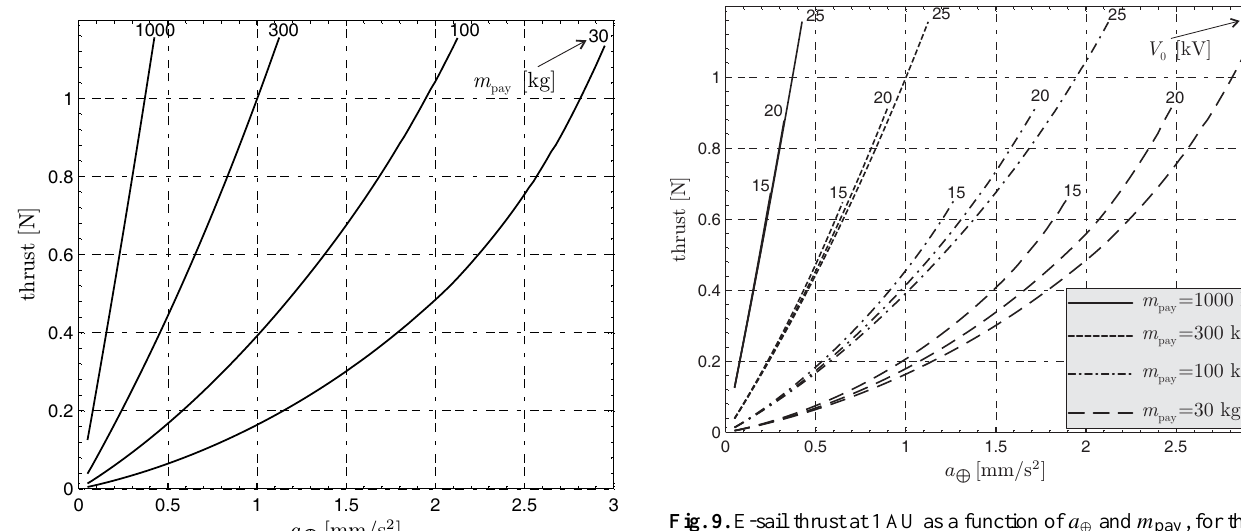
Fig. 6. Spacecraft total mass as a function of a ⊕ and m pay .